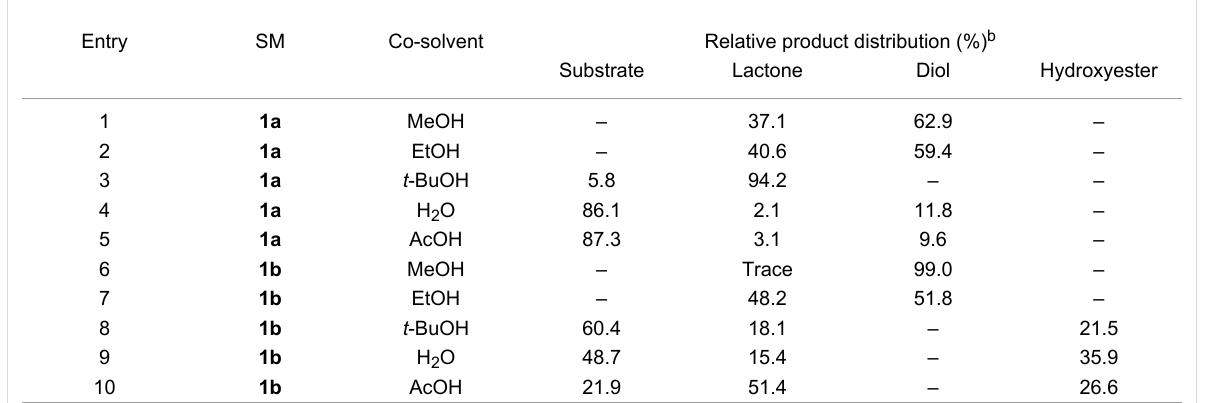
Table 2: Reactions a of 1a and 1b with NaBH 4 in anhydrous ether in the presence of protic polar co-solvents. Entry